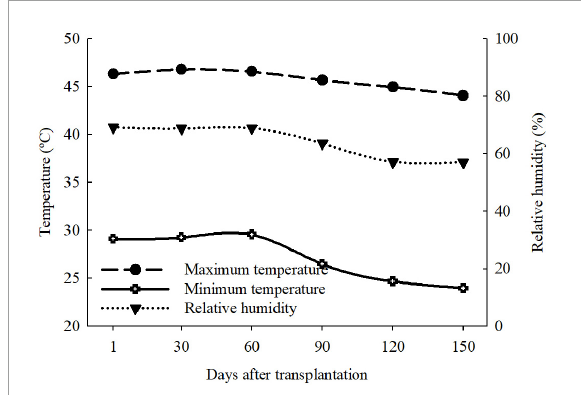
FIGURE1 Temperature and relative humidity of the air during the experimental period of cultivation with absence (0.0 mM) and presence of fertigated Si (1.8 mM) and two water conditions (35 and 70%) in three tropical soils (Quartzarenic Neosol; Eutroferric Red Latosol; and Dystrophic Red